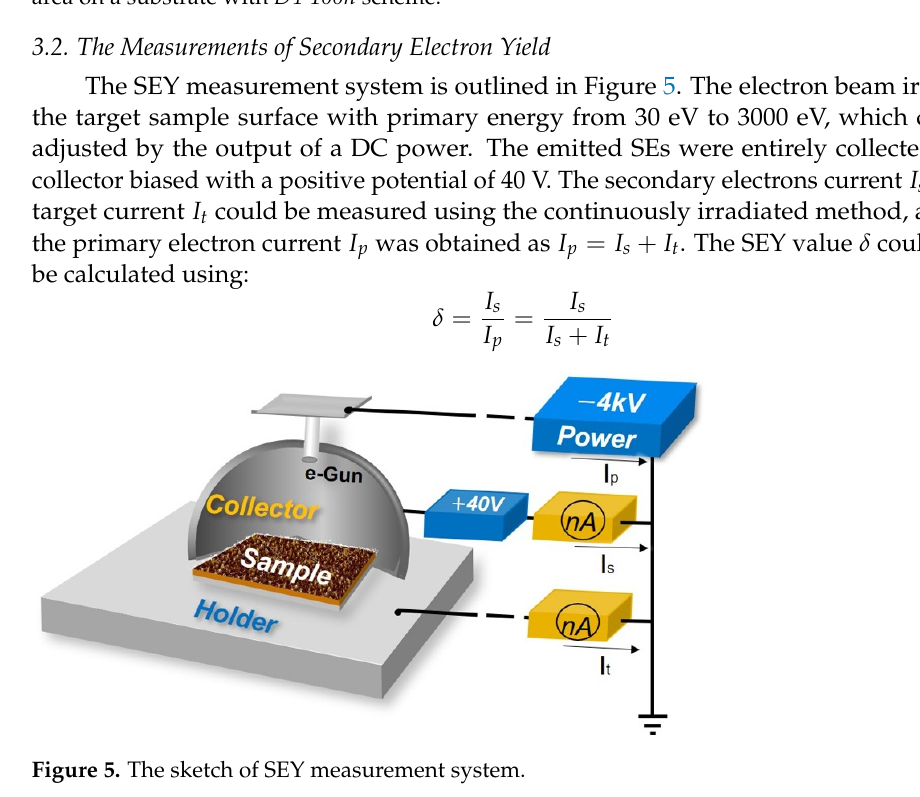
Figure 6. Measured SEY curves as a function of primary electron energy before and after the etching and gold coating. The red shadow area with dotted line in it represents the error from multiple measurements. Table 3. The δ m values of the substrates treated with different schemes of process parameters. Scheme 2.03 * -100n and -500n represent 100 nm- and 500 nm-thick gold coatings, respectively . 4. Discussion In this paper, a preliminary exploration of the effect of surface morphology on the SEY of metal surfaces was carried out. Based on an analysis of surface characterization and SEY measurements, the common surface characteristics for low SEY were found to be